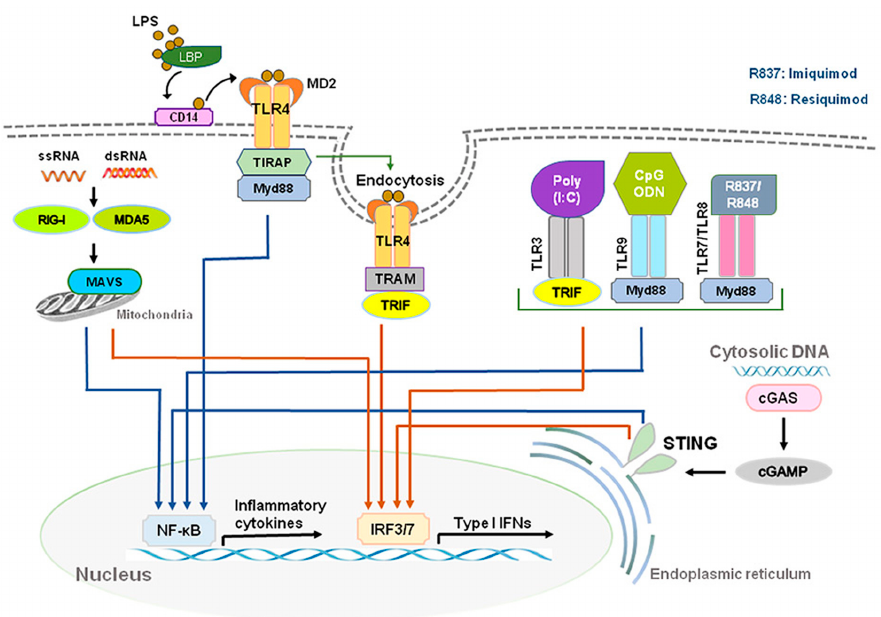
Figure 1. Production of type I IFNs. Type I IFNs are induced by activation of toll-like receptors (TLRs) and stimulator of interferon genes (STING). Abbreviations: CD14, cluster of differentia- tion 14; LBP, LPS-binding protein; LPS, lipopolysaccharide; MD2, myeloid differentiation